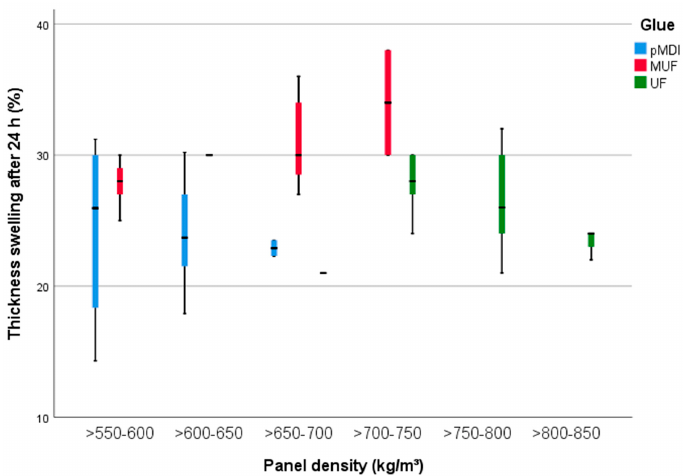
Figure 8. Thickness swelling after 24 h of the 15 mm PB with densities between 500 and 850 kg/m³ and glued with pMDI, UF and MUF. WA after 24 h (Figure 9), measured according to EN 317:1993 (34) is less influenced by the BSG amount (18%) and in an equal measure by the density and glue amount (33%). The lowest WA was detected in the case of PB manufactured with UF (from 58 to 63%) and the highest when PB were produced with pMDI (105% at 50% amount of BSG). When using MUF, the percentages of WA 24 h are ranging from 80% (for PB without BSG) to 3% (at 10%BSG).